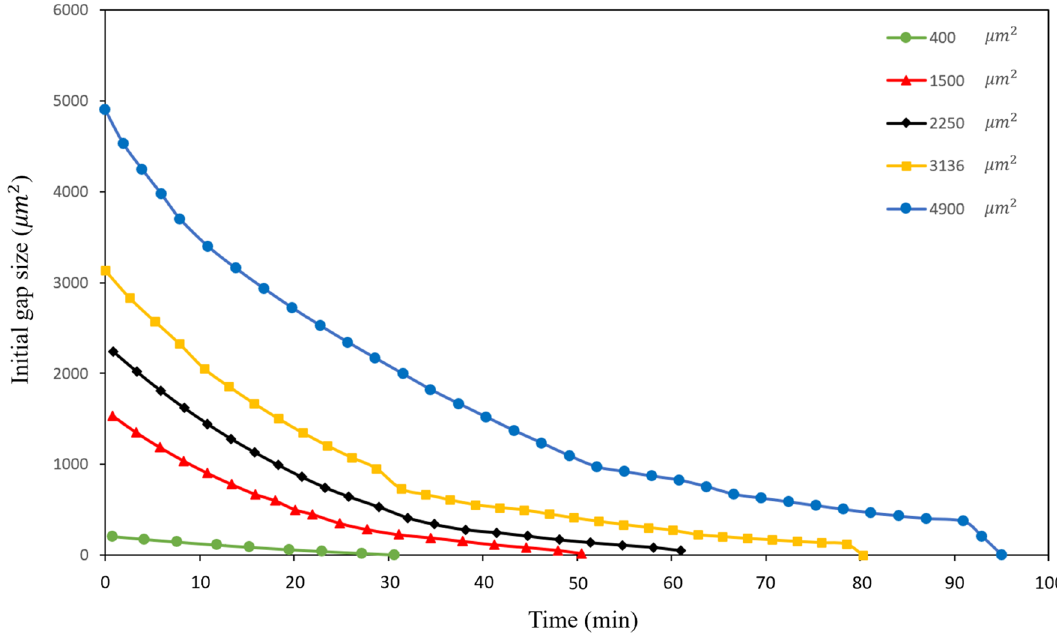
2 2 to 4900 µ m .